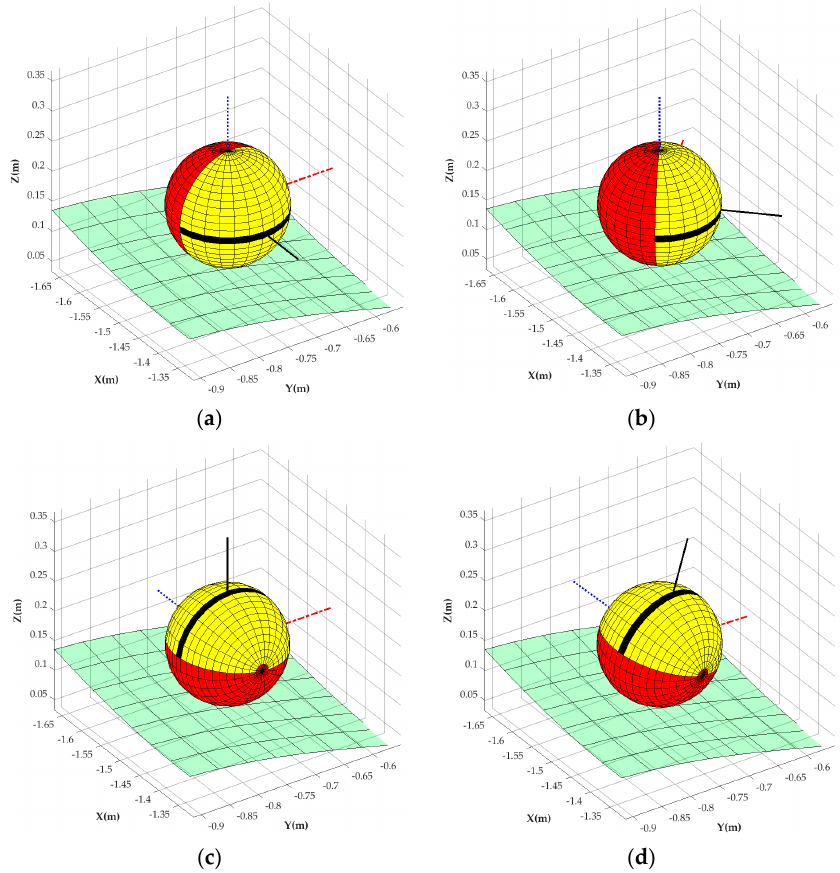
Figure 4. Initial orientation of the shell showing the initial orientation of the ˆ x ˆ y ˆ z body-fixed axis relative to the inertial XYZ frame. ( a ) Case A, ( b ) Case B, ( c ) Case C, ( d ) Case D.